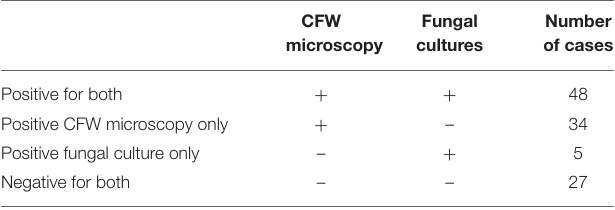
TABLE 2 | CFW microscopy and fungal culture results.